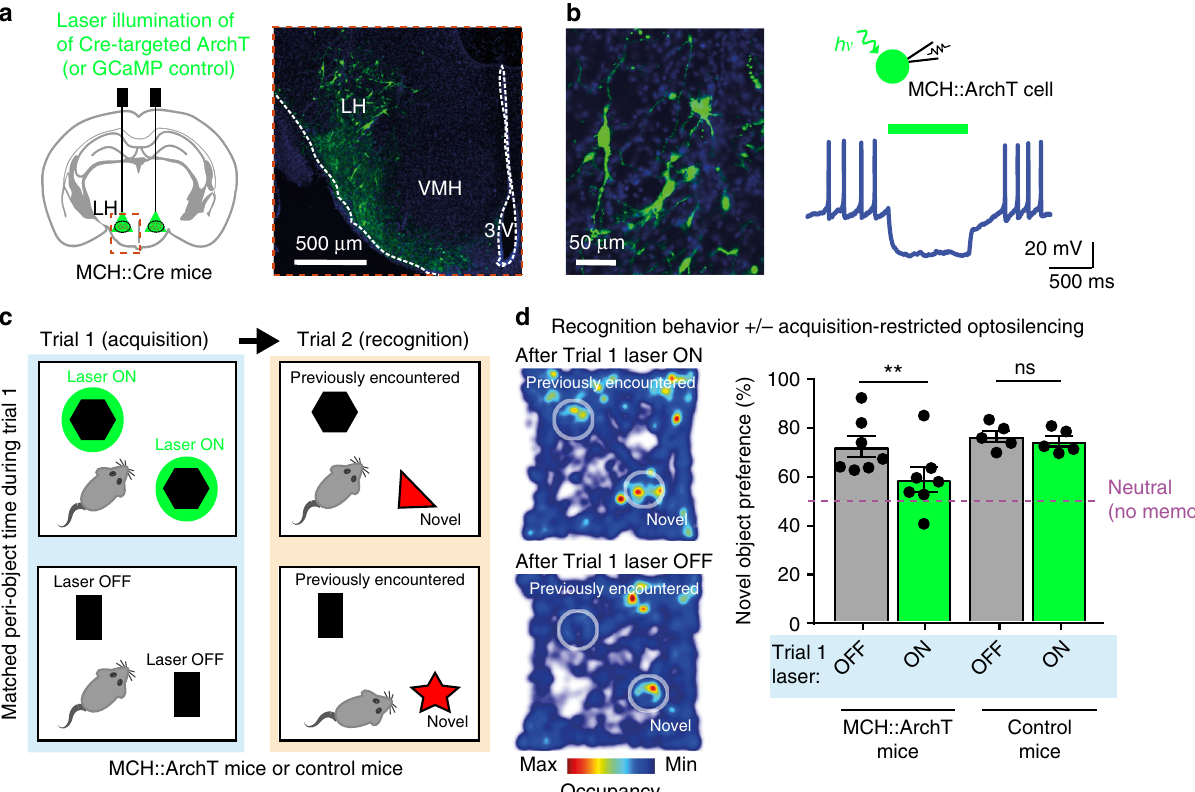
Fig. 2 Natural MCH cell bursts gate object memory formation. a Targeting scheme (left) and expression (right) of ArchT in MCH LH cells. b Patch-clamp recording (right) con fi rming silencing of MCH LH ::ArchT-YFP cells (left) by green light ( n = 5 cells). c Experimental scheme: self-paced exploration of two identical novel objects for the same cumulative peri-object time (trial 1) followed by quantifying exploration of the same arena with one of the previously encountered objects replaced by a novel object (trial 2). d Left: sample heatmaps showing relative time spent with objects on trial 2. Right: group data (individual points and their means ± s.e.m). Object-area-entry-coupled bilateral LH laser illumination during trial 1 reduced object recognition in trial 2 in MCH LH ::ArchT mice ( n = 7) but not in control (MCH LH ::GCaMP) mice ( n = 5) (2-way ANOVA: F (1, 8) = 7.43, p = 0.0260, Sidak ’ s multiple comparisons test: ** p = 0.0034, ns = p = 0.7073). In MCH LH ::ArchT mice, trial 1 laser ON group, the preference for the novel object during trial 2 was not different from